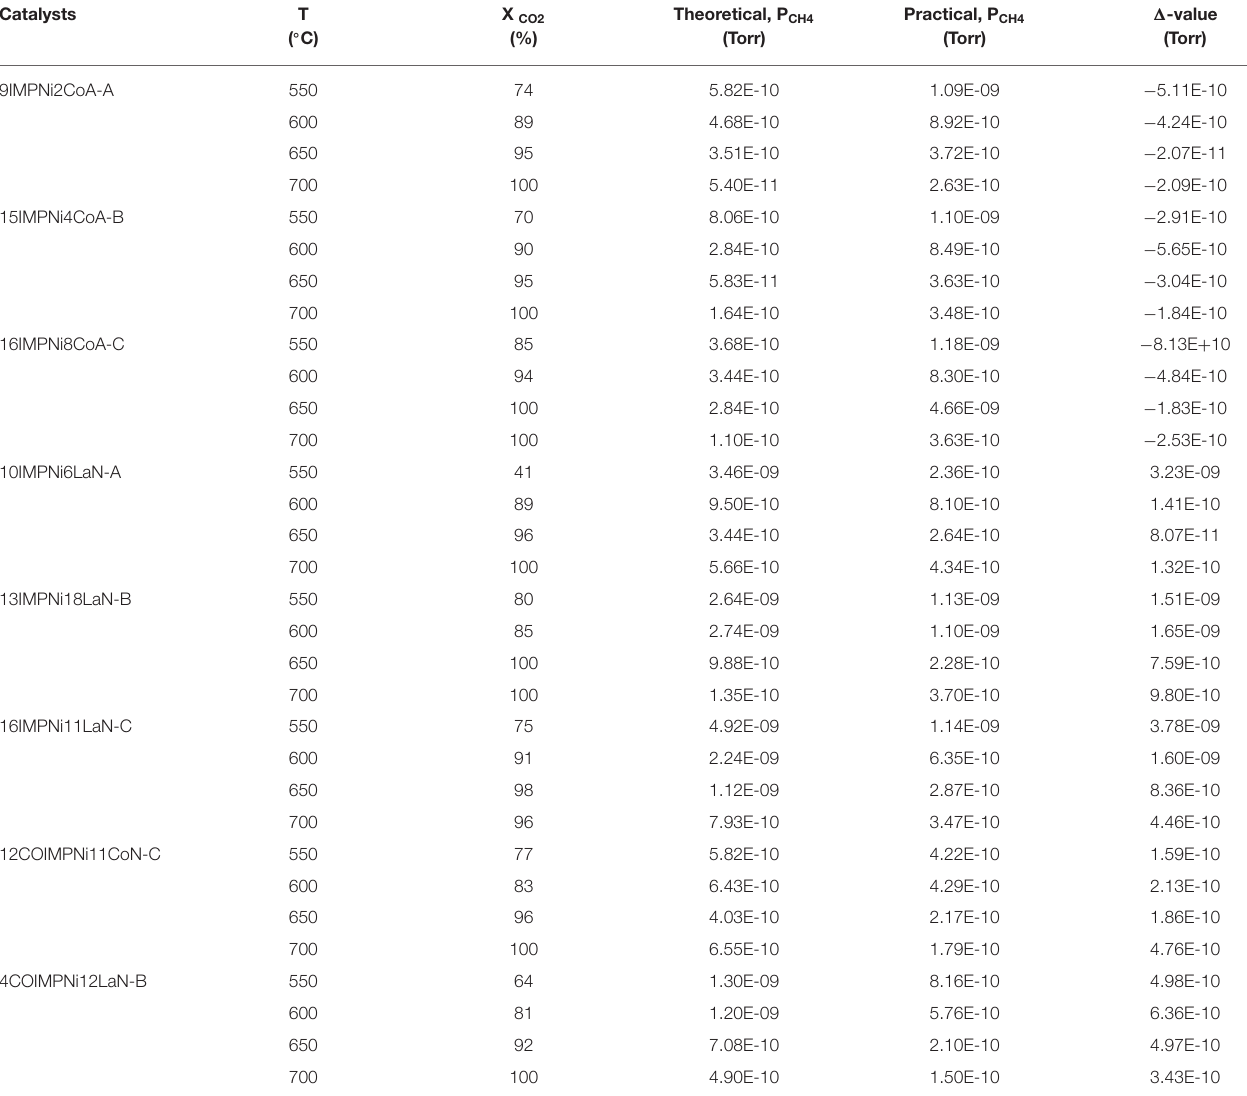
TABLE 4 | Calculated compared with measured methane pressure (leaving the microreactor) and CO 2 conversion for the bimetallic Ni-M/SBA-15 catalyst samples (M = Co and La) (prepared by sequential impregnation and co-impregnation), at 550, 600, 650, and 700 ◦ C, respectively. Catalysts T ( ◦